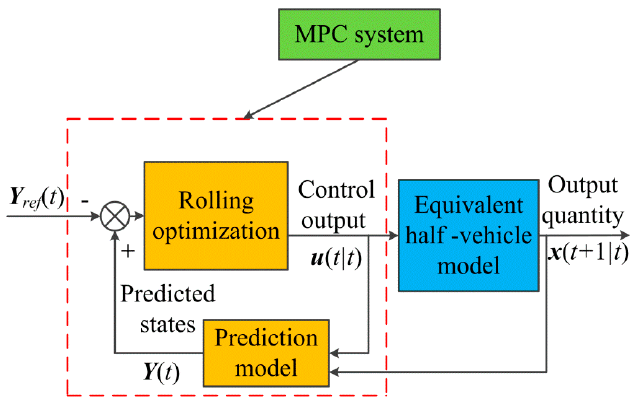
Figure 2. Basic block diagram of the model predictive control (MPC) strategy.